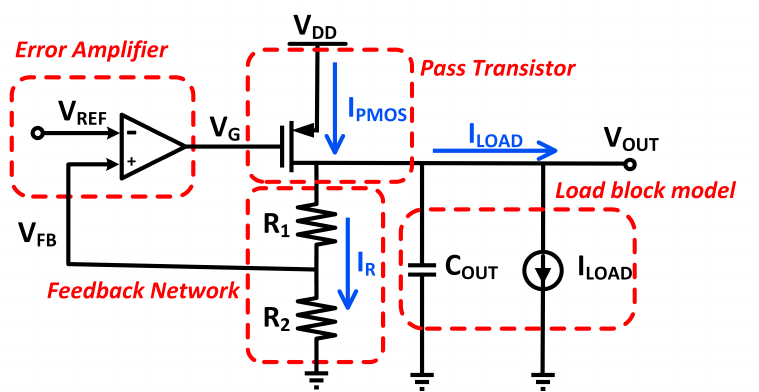
Figure 3. Conventional LDO regulator.